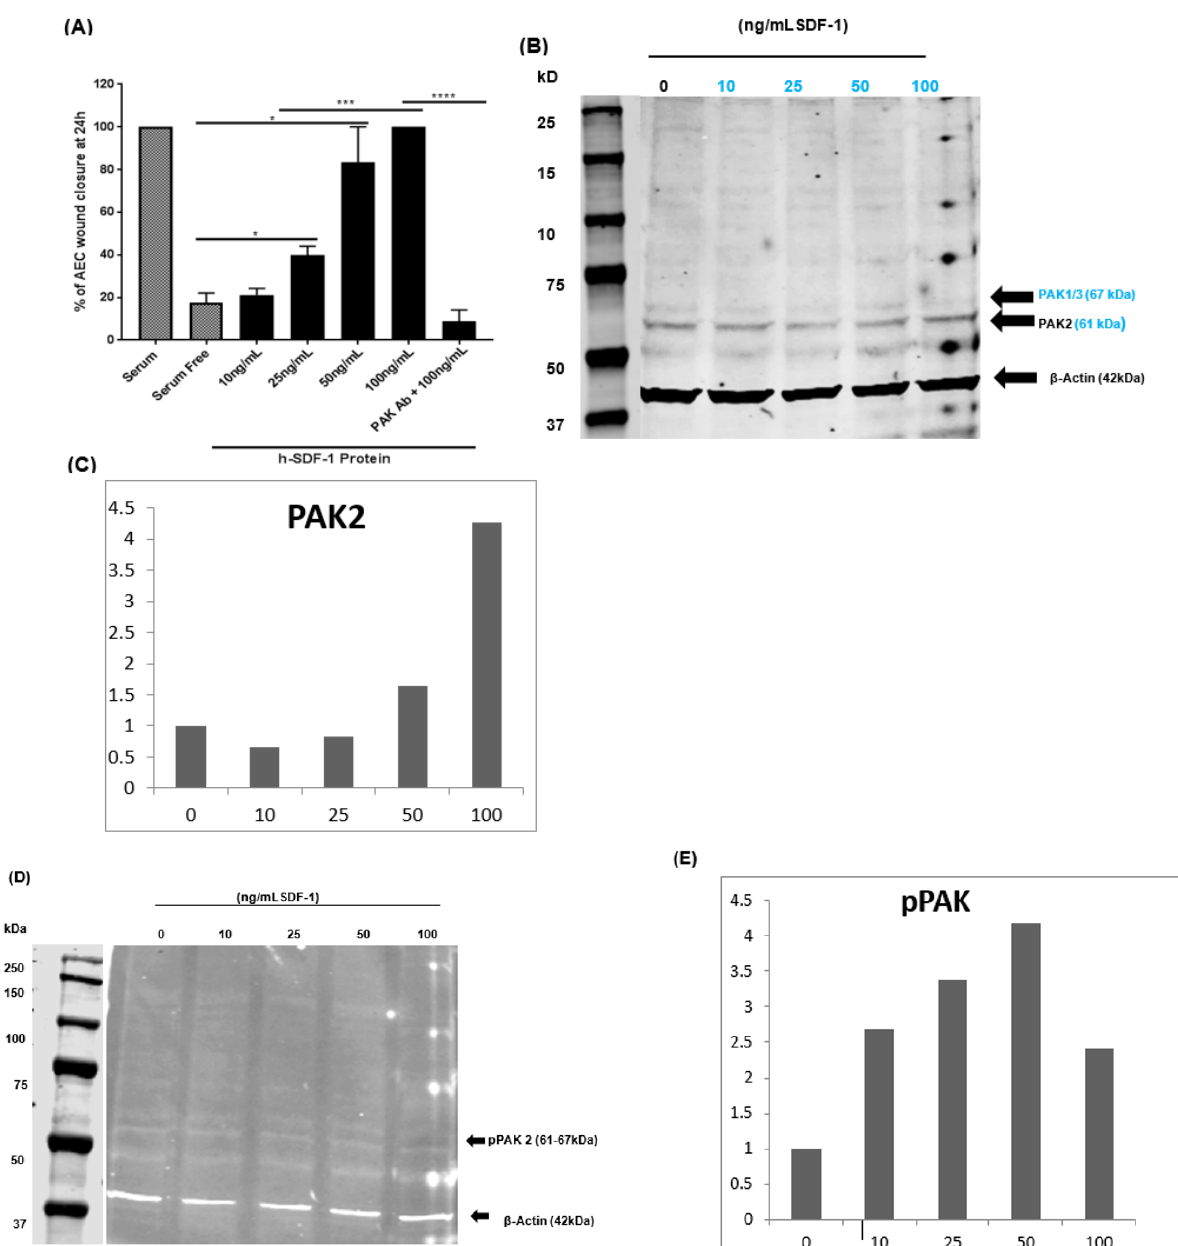
Figure 8. SDF-1 increases alveolar epithelial cell wound healing and induces migration via PAK pathway. Alveolar epithelial cells’ (A549) wound healing was improved after SDF-1 treatment in a dose-dependent manner in in vitro scratch assay ( A ). A549 cells treated with SDF-1 western blot analysis revealed increased PAK 2 in dose-dependent manner ( B – D ). Moreover, the phosphorylation of PAK was also observed after SDF-1 treatment ( E ). (Mean±SEM *: p < 0.05, ***: p < 0.001, ****: p < 0.0001).